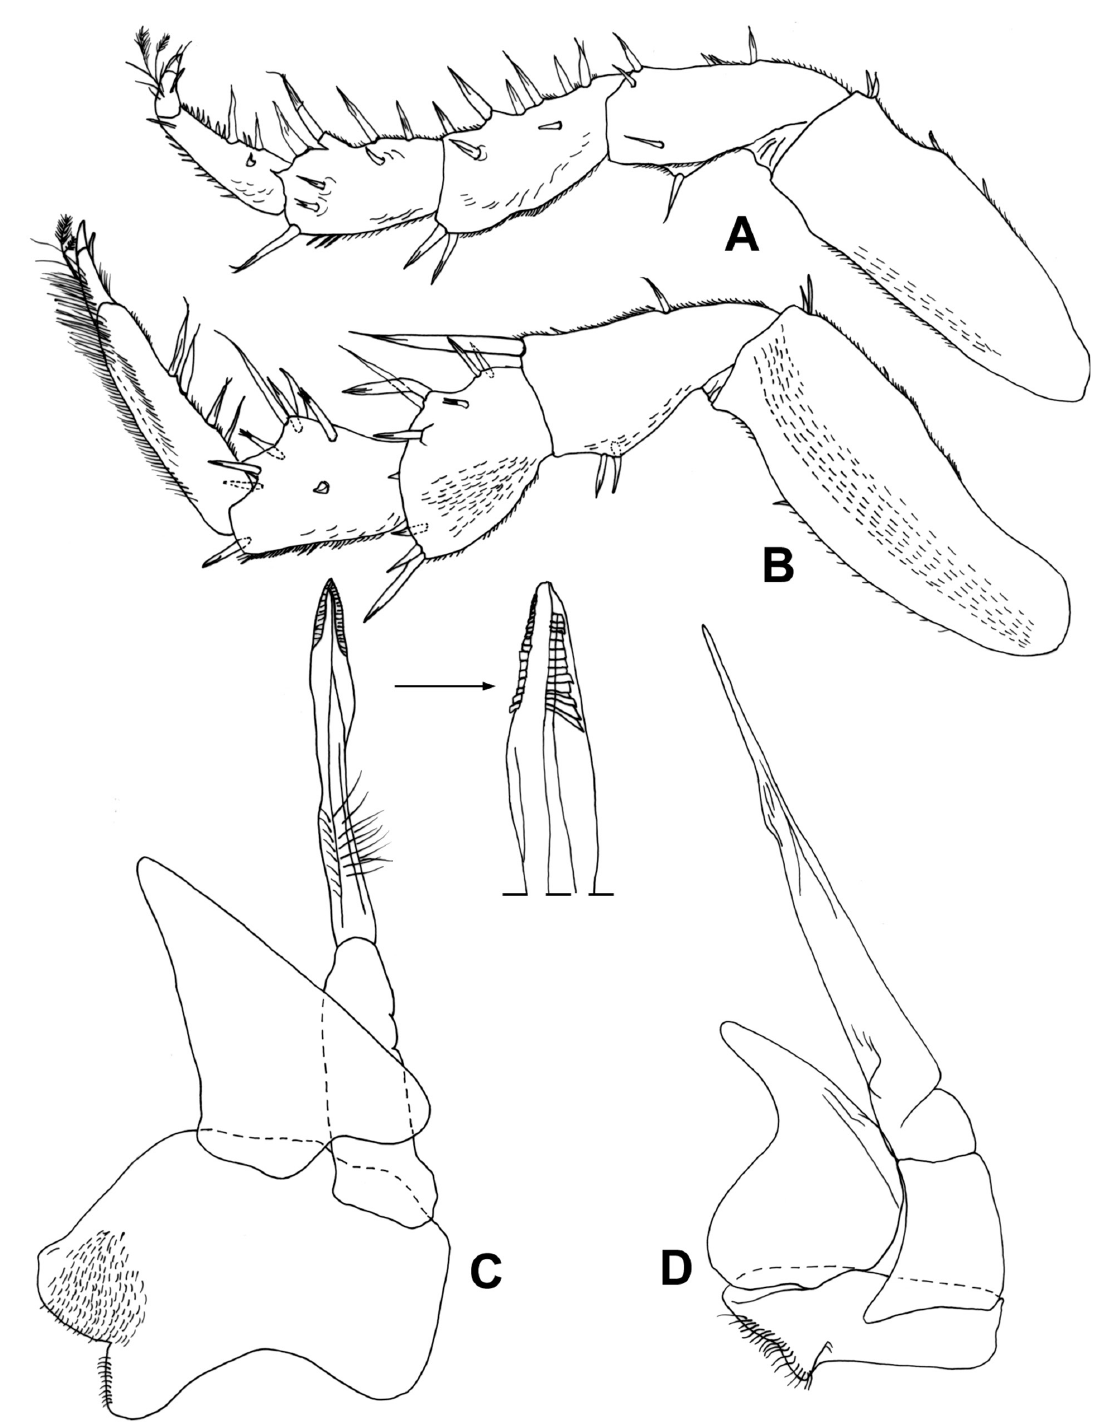
Fig. 20. Miktoniscus longispina Reboleira & Taiti sp. nov. from Gruta dos Bolhos, Cesaredas Plateau, paratype, ♂. A . Pereopod 1. B . Pereopod 7. C . Pleopod 1. D . Pleopod